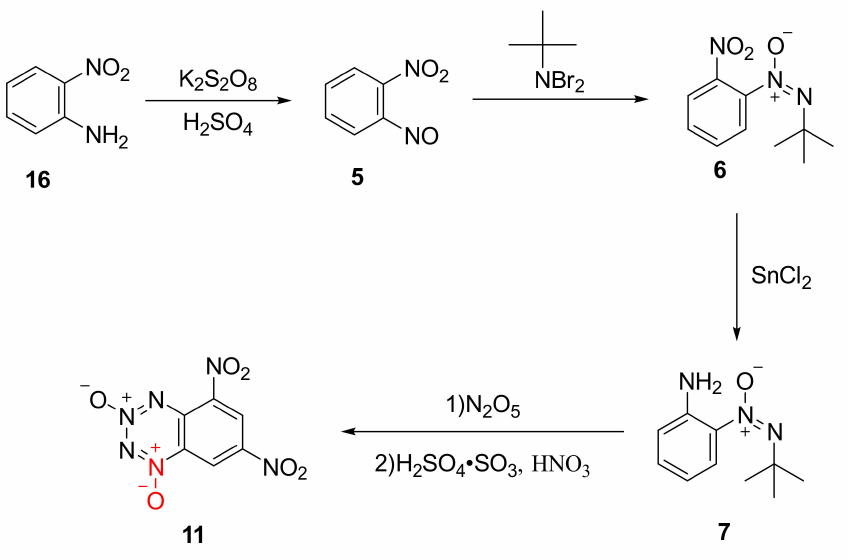
Scheme 3. Synthetic route for compound 11